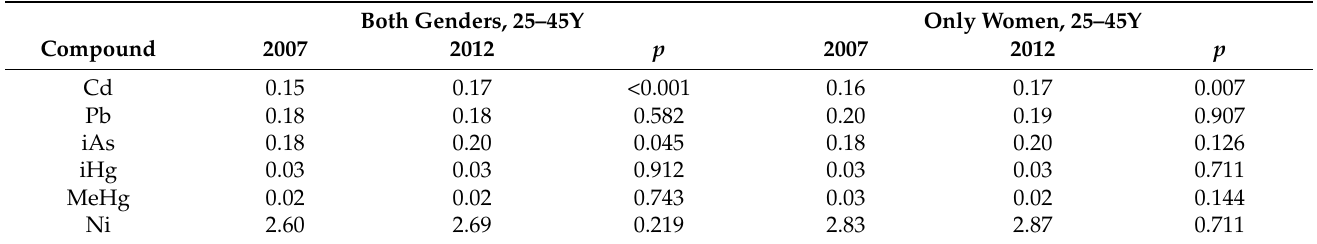
Table 7. Statistical comparison of the average exposure (in µ g/kg bw/d) in the age group 25 to 45 years, compared between the two years. In the first columns, the age groups were not divided by gender, while the right-hand columns only compare women of 25 to 45 years. Individual daily exposure values were used, and in the t -test, equal variances were not